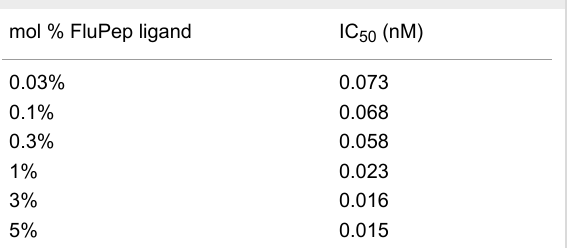
Table 1: IC 50 values of gold nanoparticles functionalised with different molar fractions of FluPep ligand.